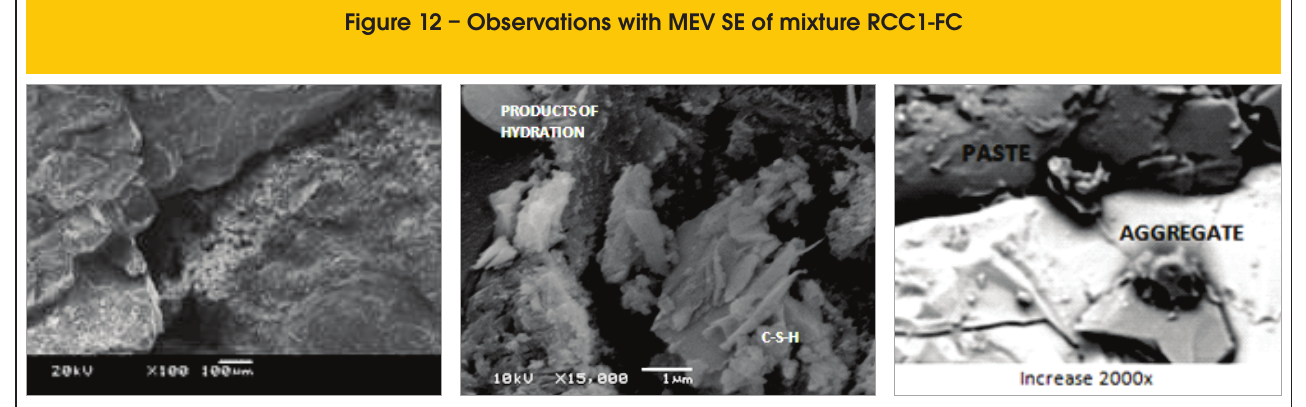
Figure 12 – Observations with MEV SE of mixture